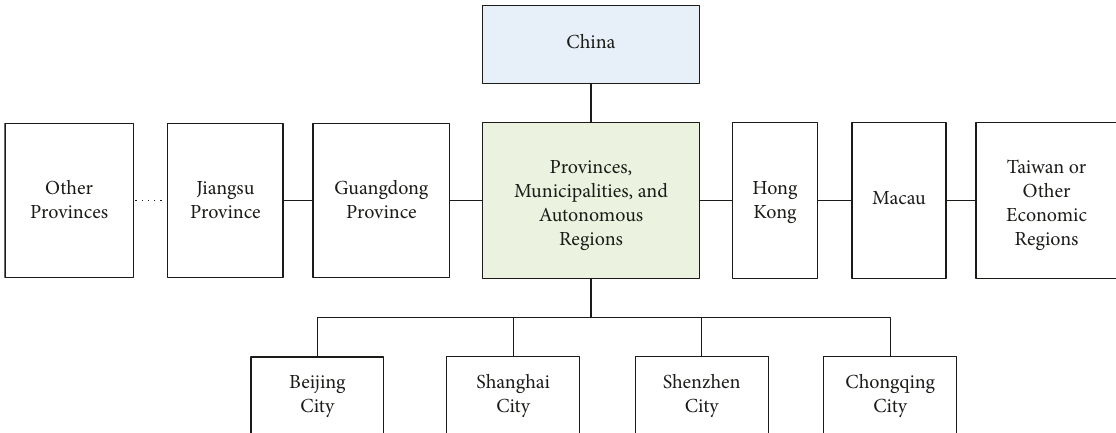
Figure 8: Regional economy simulation system (source: Guangzhou Milestone Software Co., Ltd., China).